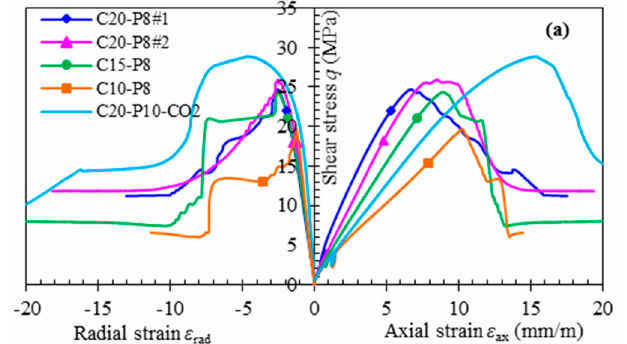
Figure 4. Stressstrain plot summarizing all triaxial tests performed on the Draupne shale.